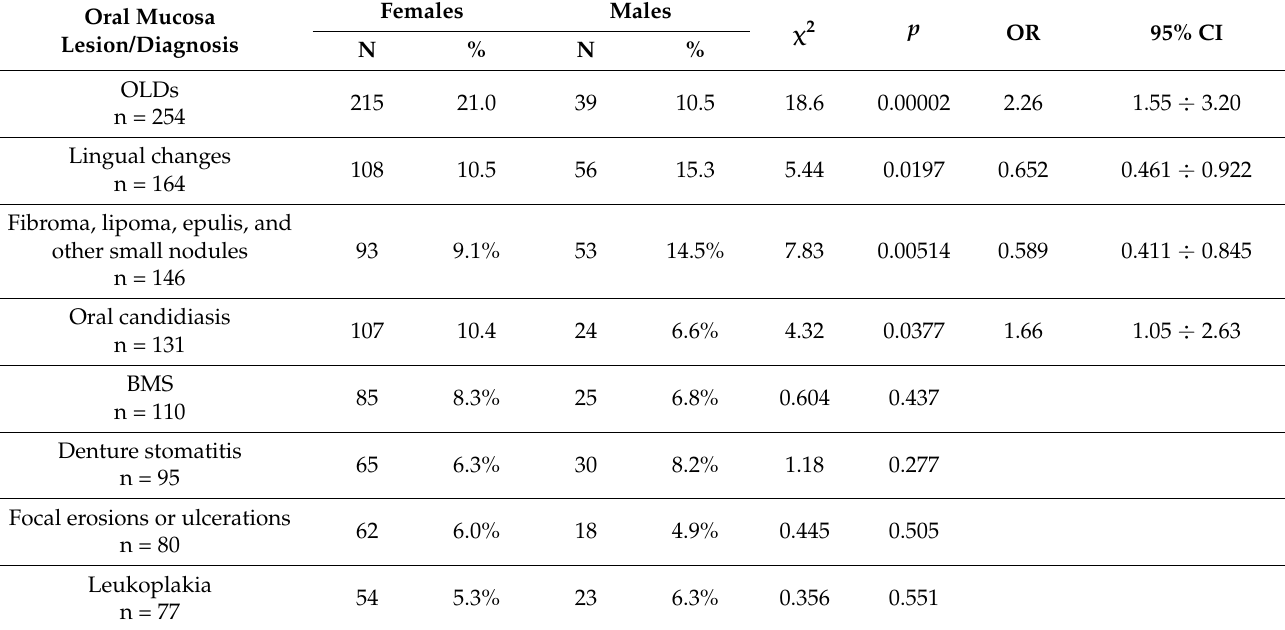
Table 2. The frequency of oral lesions in connection with gender.